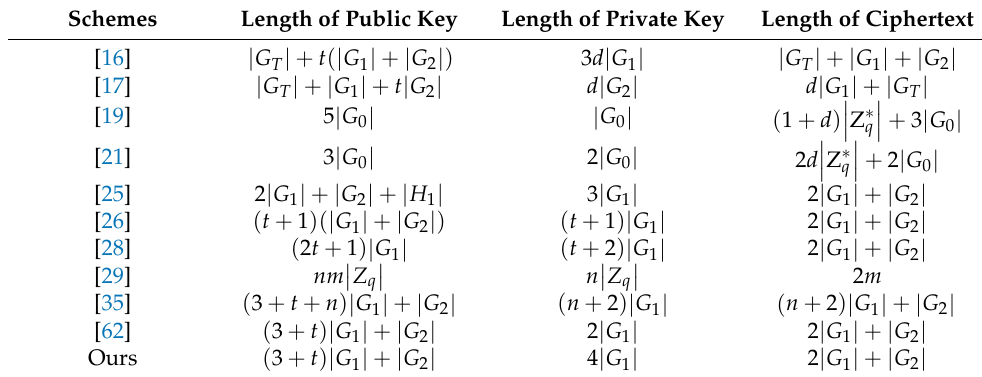
Table 3. Comparisons of Storage Efficiency.